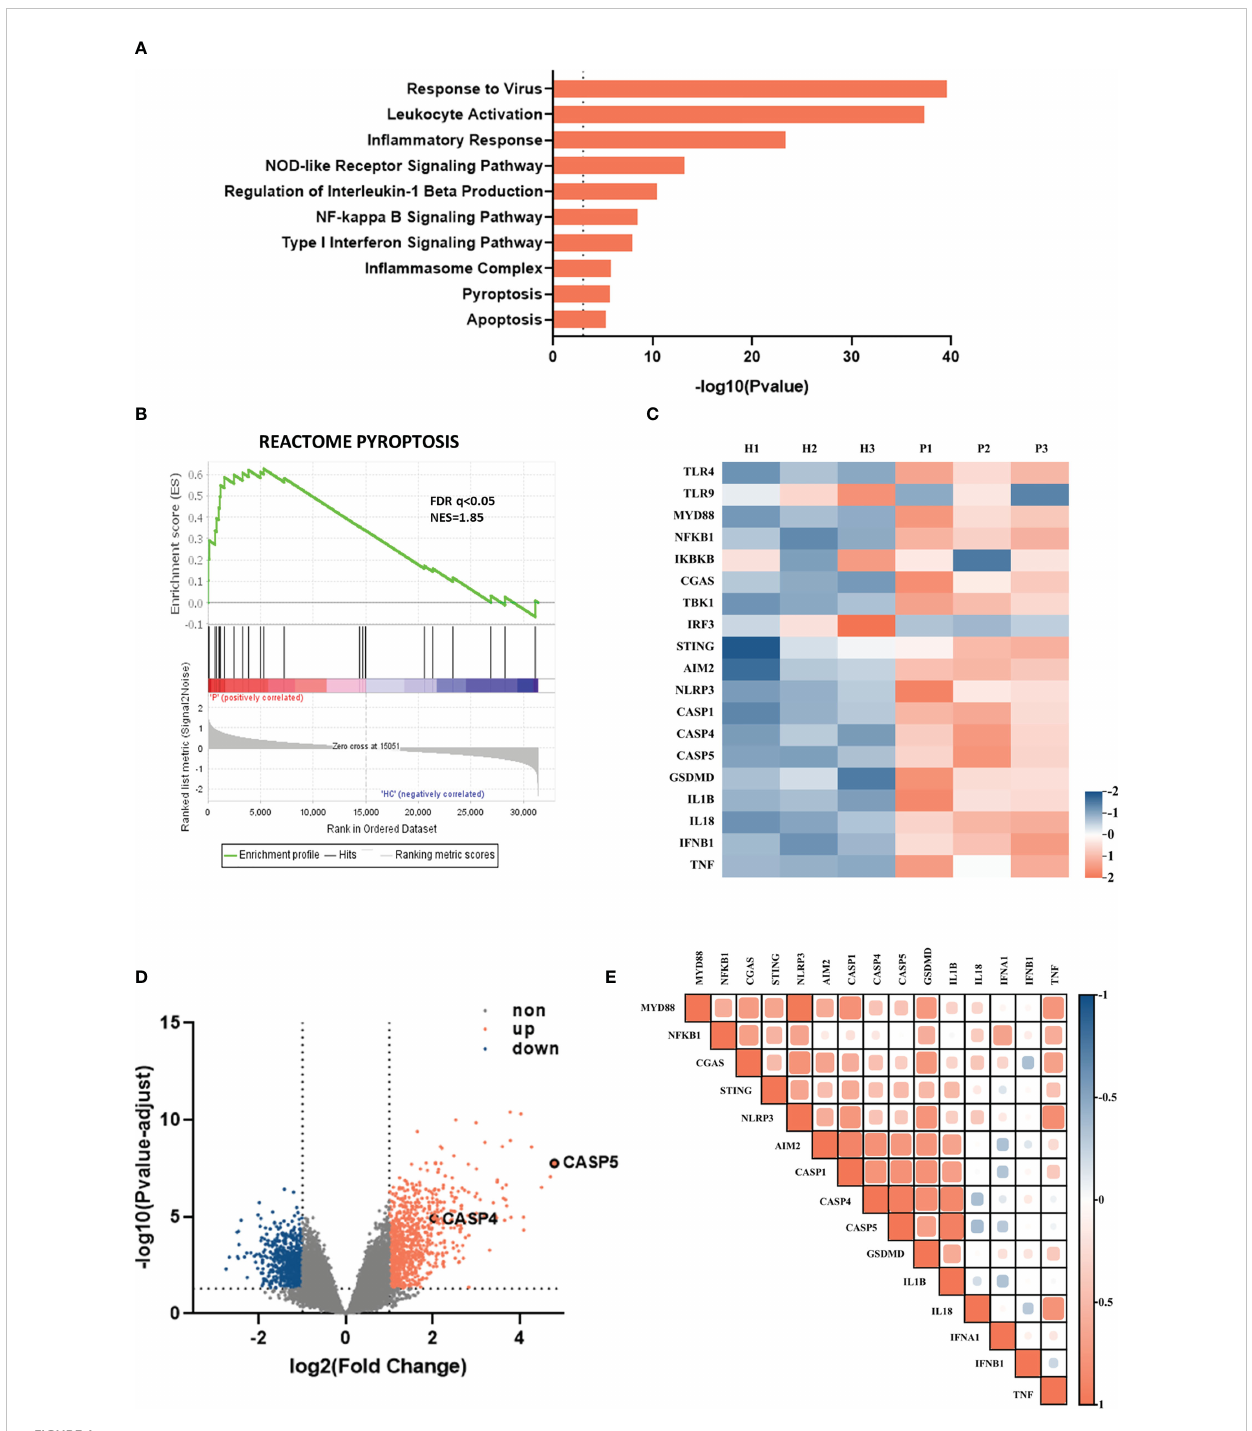
FIGURE 1 In fl ammasome-related genes and signaling pathways were enriched among children hospitalized with viral pneumonia. The data, downloaded within the GSE103119 dataset on the GEO database, were normalized using quantile normalization with the lumi package in R. (A) Enrichment analysis showing some of signi fi cantly enriched signaling pathways in viral pneumonia pediatric patients compared to healthy controls. (B) GSEA enrichment plot of the pyroptosis pathway. (C) Heatmap depicting the expression pro fi ling of in fl ammasome-related DEGs in adenovirus pneumonia pediatric patients compare to healthy controls. (D) Volcano plot of DEGs in adenovirus pneumonia children and healthy control. (E) Heatmap of pairwise correlation of in fl ammation-related genes expression with caspase-4 and